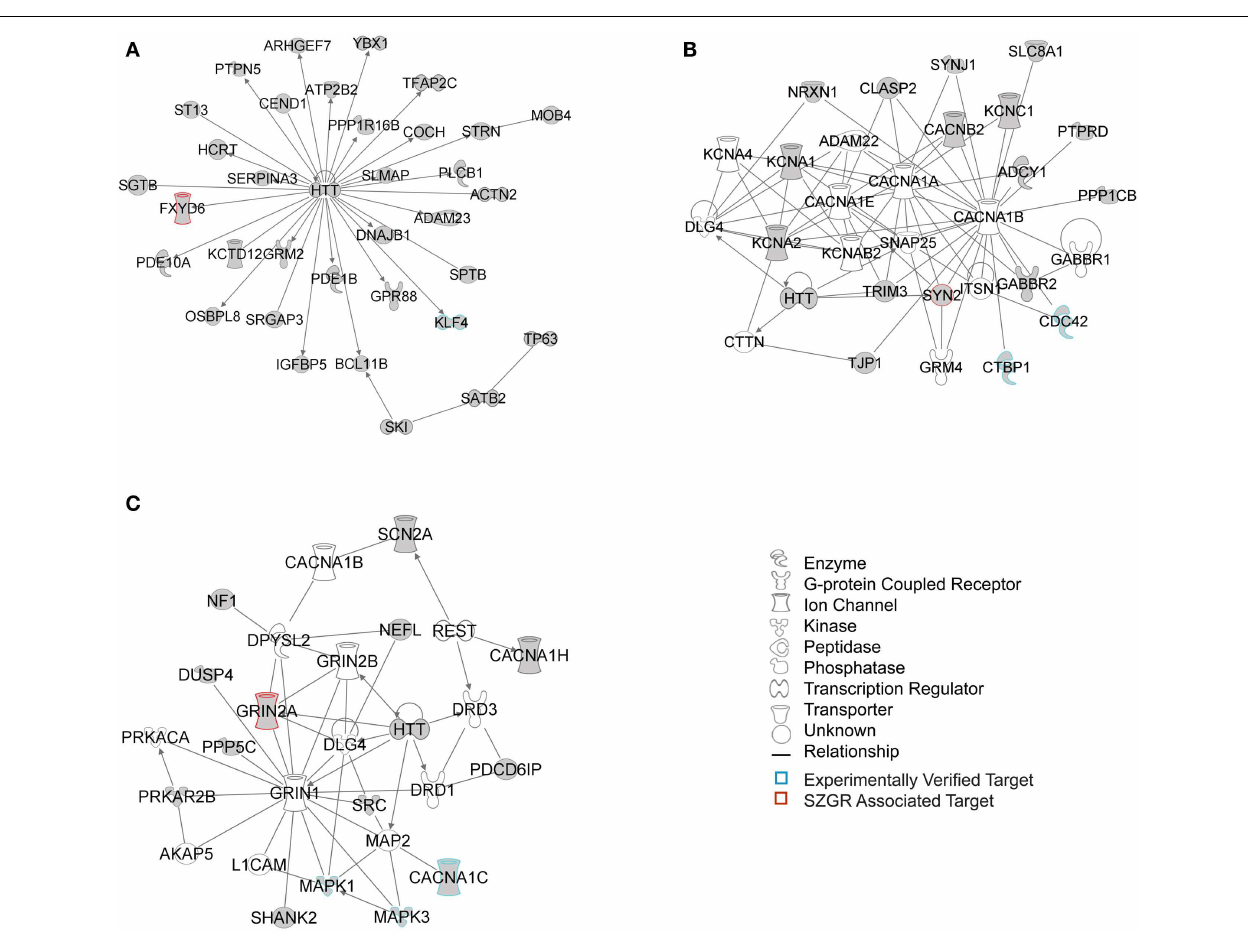
score of 8.White molecules are those not included in the uploaded dataset but added by IPA. Gray molecules indicate those that were included in the uploaded dataset. Relationships depicted by lines with arrows represent “act on,” while lines without arrows represent binding. See figure legend keys for identification of the types of molecules included. Blue outlines depict experimentally validated targets and those in red indicate SZGR associated